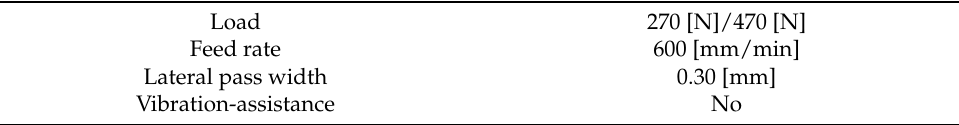
Table 3. Ball-burnishing operational parameters.